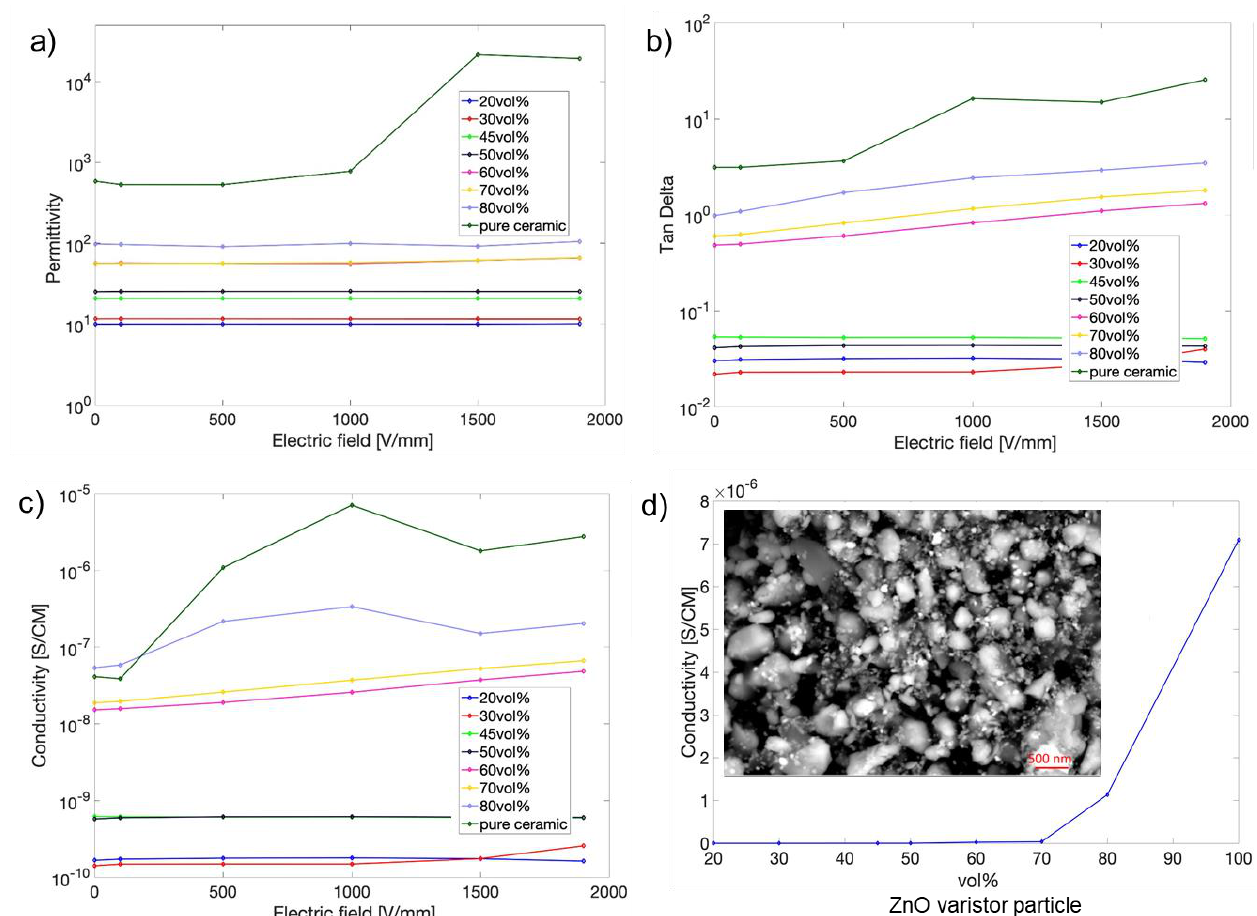
Figure 7. Electric field dependence of ( a ) permittivity, ( b ) loss factor, ( c ) conductivity of the composites filled with different vol% ZnO varistor particles, and ( d ) conductivity as a function of vol% ZnO varistor and the SEM image of the fillers of 80 vol%.